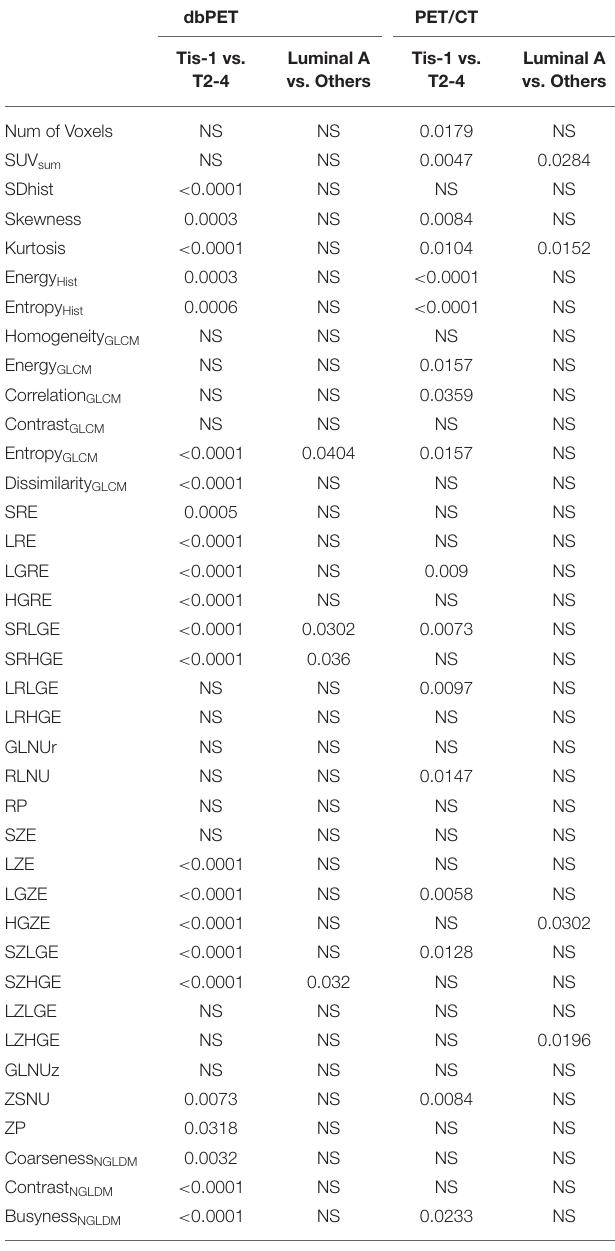
TABLE 2 | Associations ( p-value ) between texture PET parameters and tumor